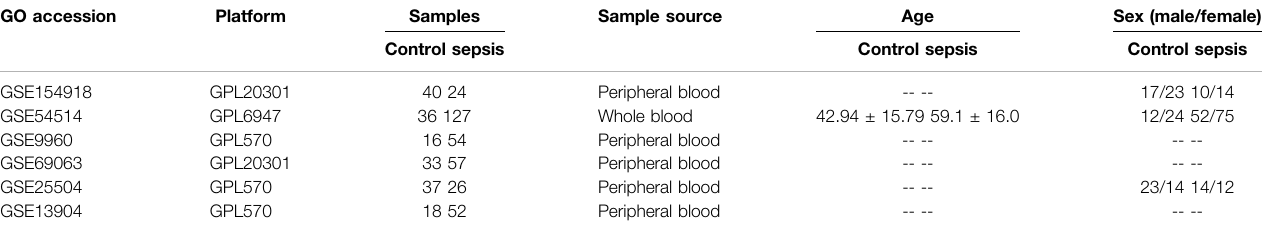
TABLE 1 | Information for selected microarray datasets.